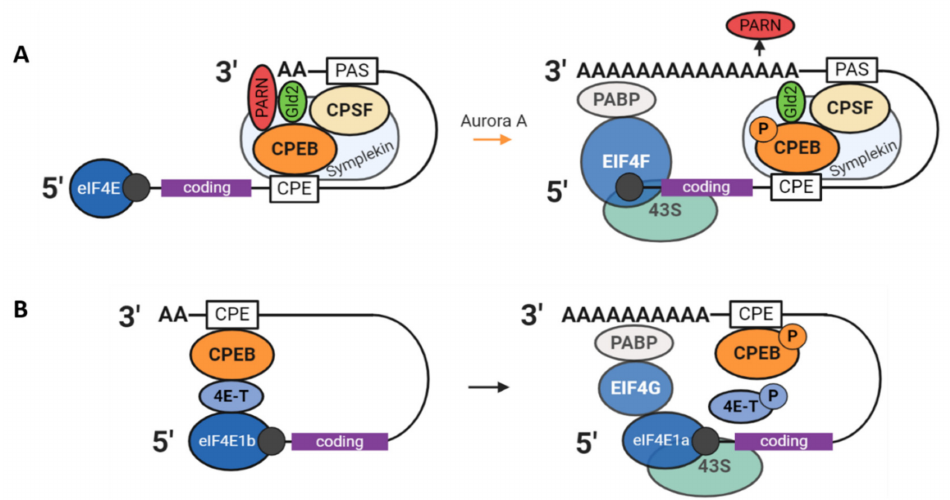
Figure 7. Models of regulation of mRNA translation by CPEB1 and associated proteins. ( A ) Poly(A) regulation via PARN and Gld2 as described in Xenopus . The transition from translational repression to activity occurs via phosphorylation of CPEB1 by the kinase Aurora A. Trimeric eIF4F comprises eIF4E, eIF4A, and eIF4G. ( B ) Proposed model of translation regulation through binding of 4E-T with CPEB1 and eIF4E1b hindering interaction of eIF4E1a with the cap